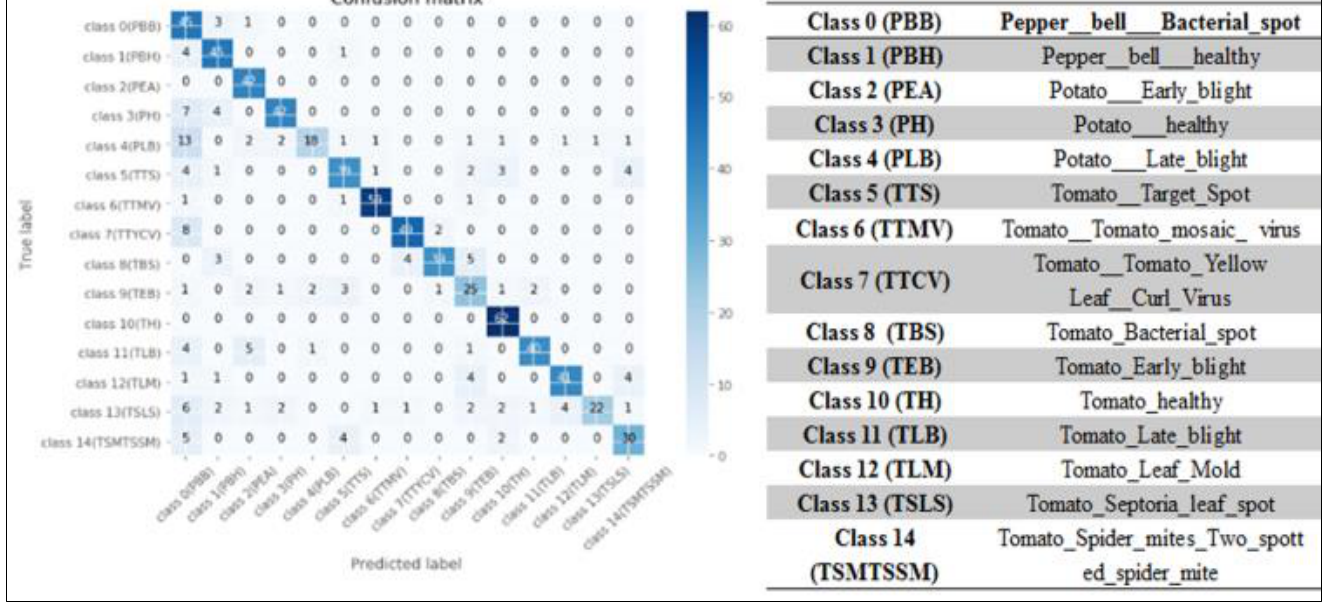
Figure 6: Confusion matrix. Source: Authors,